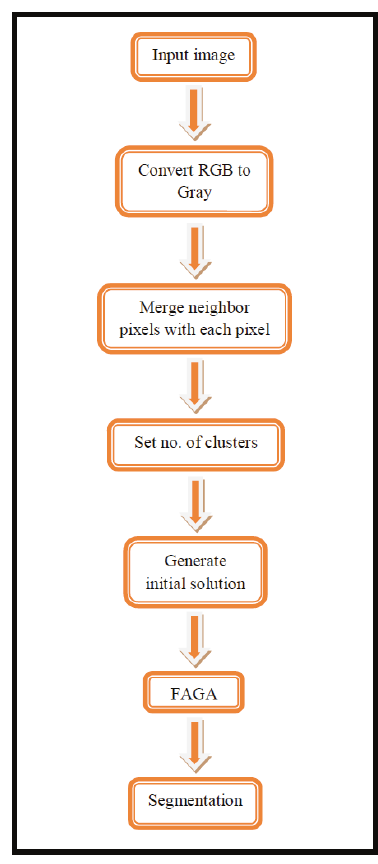
Fig.1 Process of Segmenting an